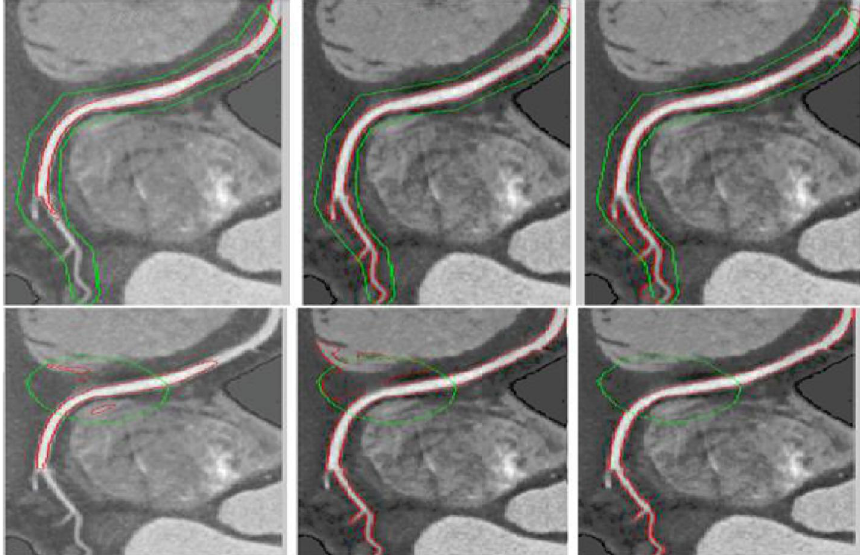
FIG. 7. SEGMENTATION EFFICIENCY OF THREE METHODS AGAINST TWO DIFFERENT INITIALIZATIONS ON CLINICAL CPR IMAGE (LEFT) LOCALIZATION METHOD. (MIDDLE) YIN’S METHOD (RIGHT) PROPOSED METHOD, GREEN IS INITIALIZATION AND RED IS FINAL